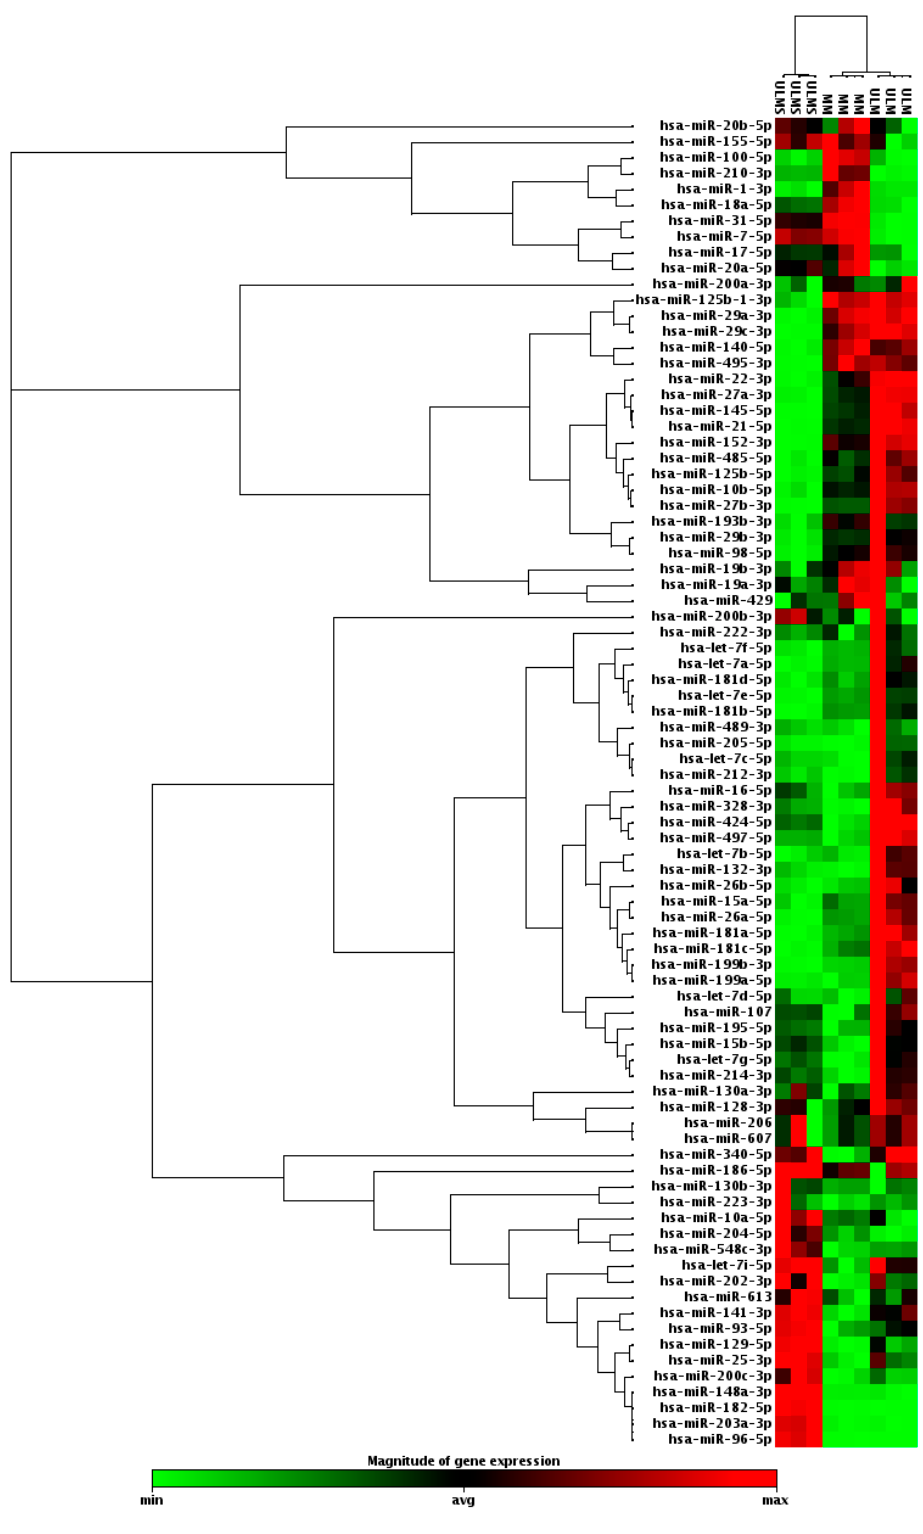
Figure 1. Clustergram analysis with profile expression of 84 oncomirs in uterine leiomyoma (ULM) and uterine leiomyosarcoma (ULMS) cells compared with myometrium (MM) cells (fold change (FC) expression cut-off values of +2 and − 2).